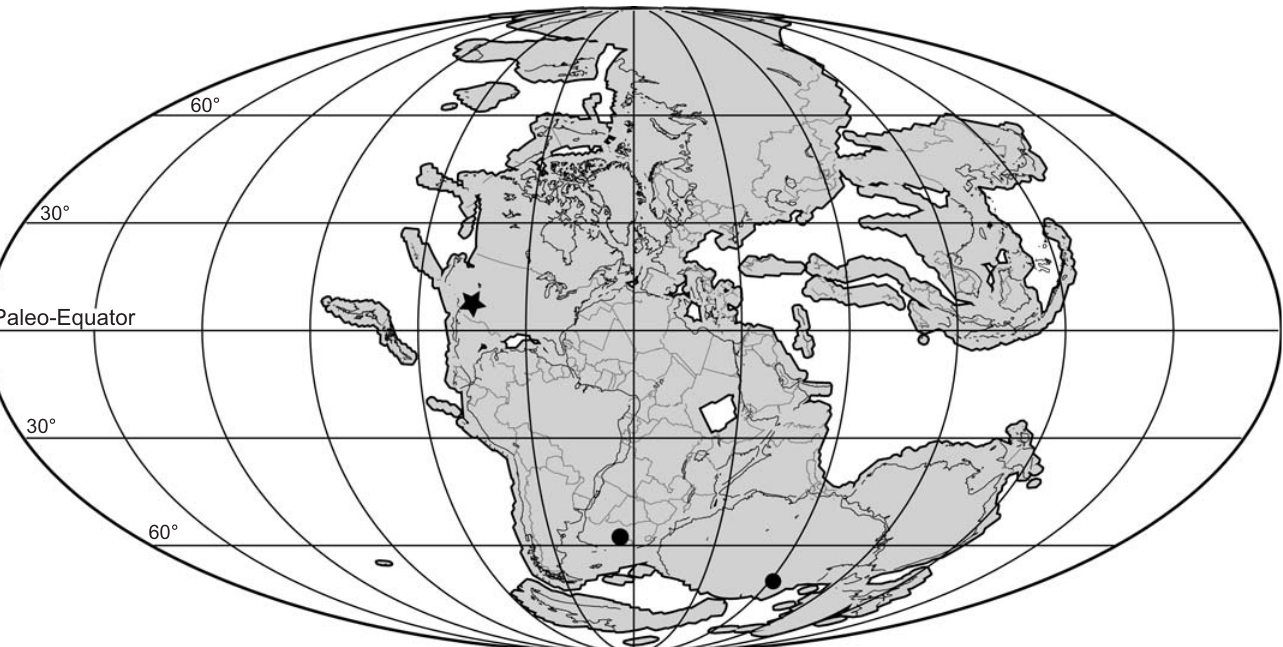
Fig. 4. Paleoreconstruction map of Pangaea in the Triassic with Gondwanan occurrences of Palacrodon marked with circles and Laurasia occurrences of Palacrodon marked with a star (note the two Arizona occurrences overlap in this scale). Paleogeography modified from www.pubs.usgs.gov/gip/dynamic/